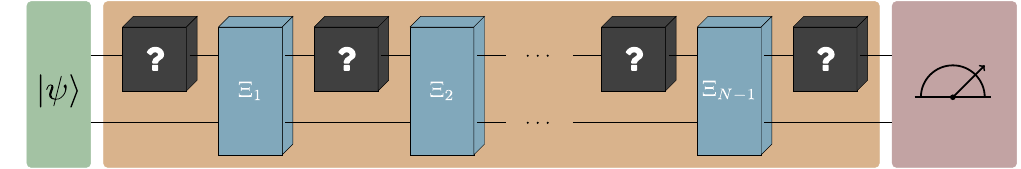
Figure 2. Adaptive certification scheme. The processings � 1 , . . . , � N where we only assume that the first subsystem must fit the input of the black box. In particular, the processings can swap subsystems, and therefore one can obtain the parallel scheme as a special case of the adaptive discrimination